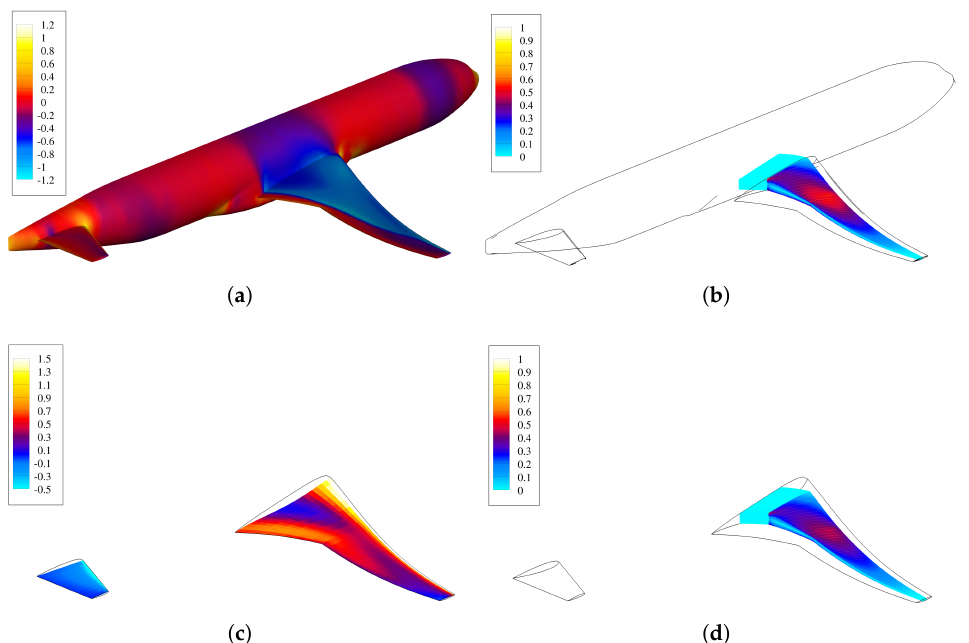
Figure 4. Pressure coefficient and stress (normalized by yield stress) at the same statically deflected de- sign. The aluminum skin, rib, and spar faces have arbitrary thicknesses of 2, 3, and 4 cm, respectively. ( a ) Pressure coefficient, Euler. ( b ) Normalized von Mises stress, Euler. ( c ) Differential pressure coefficient, VLM. ( d ) Normalized von Mises stress, VLM.